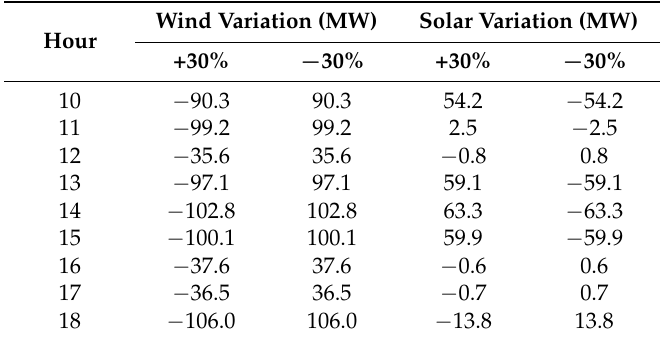
Table 3. Variations (MW) at the Paulo Afonso IV Hydroelectric Power Plant.